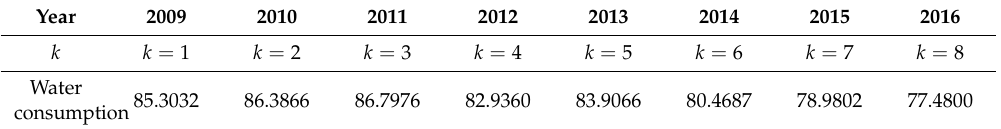
Table 1. Water consumption in Chongqing from 2009 to 2016 (Unit: hundred million cubic metres).